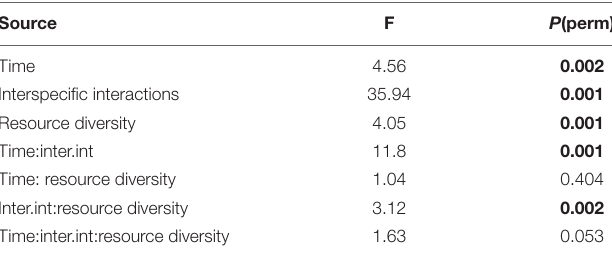
TABLE 2 | PERMANOVA results from the analysis of relative abundances of Pm I, Pm II, Pm III, and Pm IV as a function of time, resource diversity and interspecific